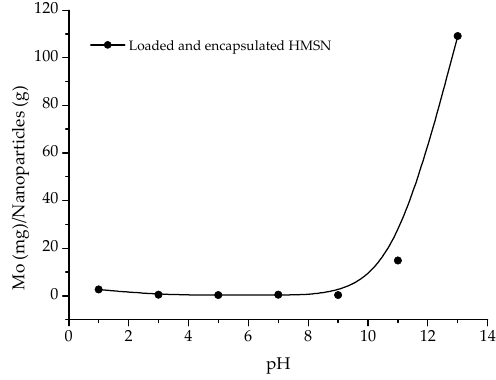
Figure 6. Inhibitor release as a function of pH.